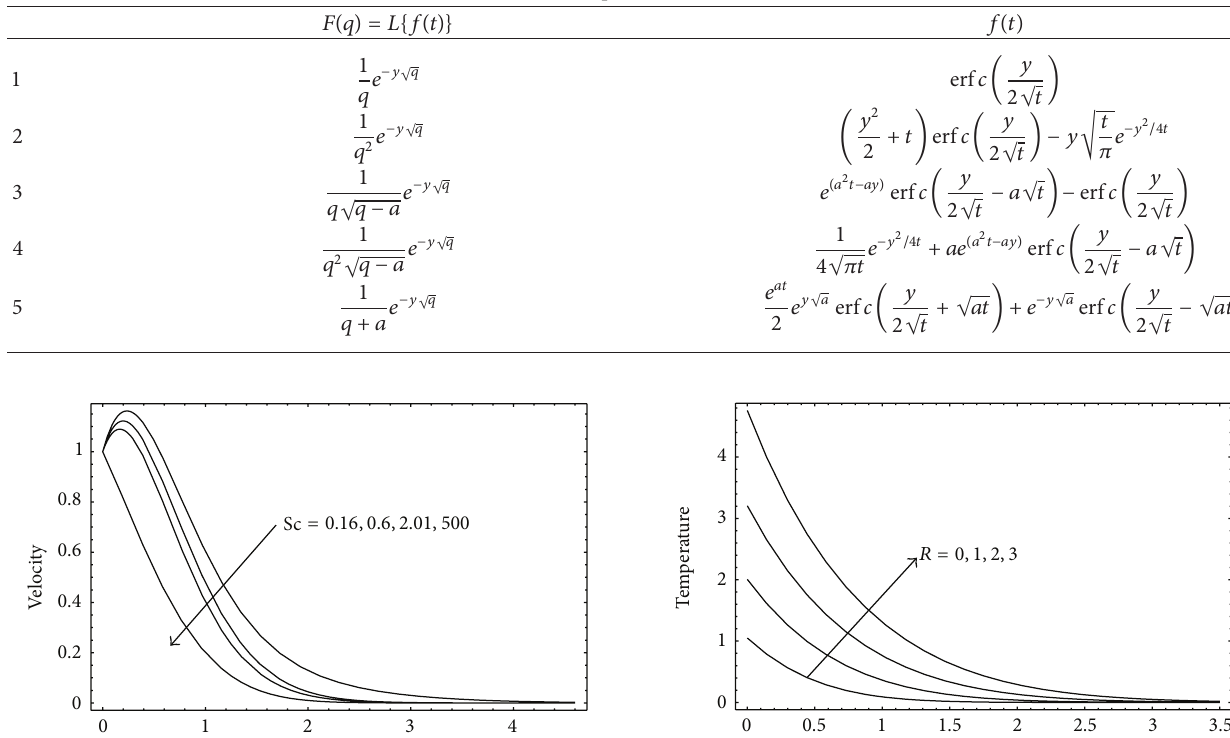
Table 4: Inverse Laplace transform formulae.